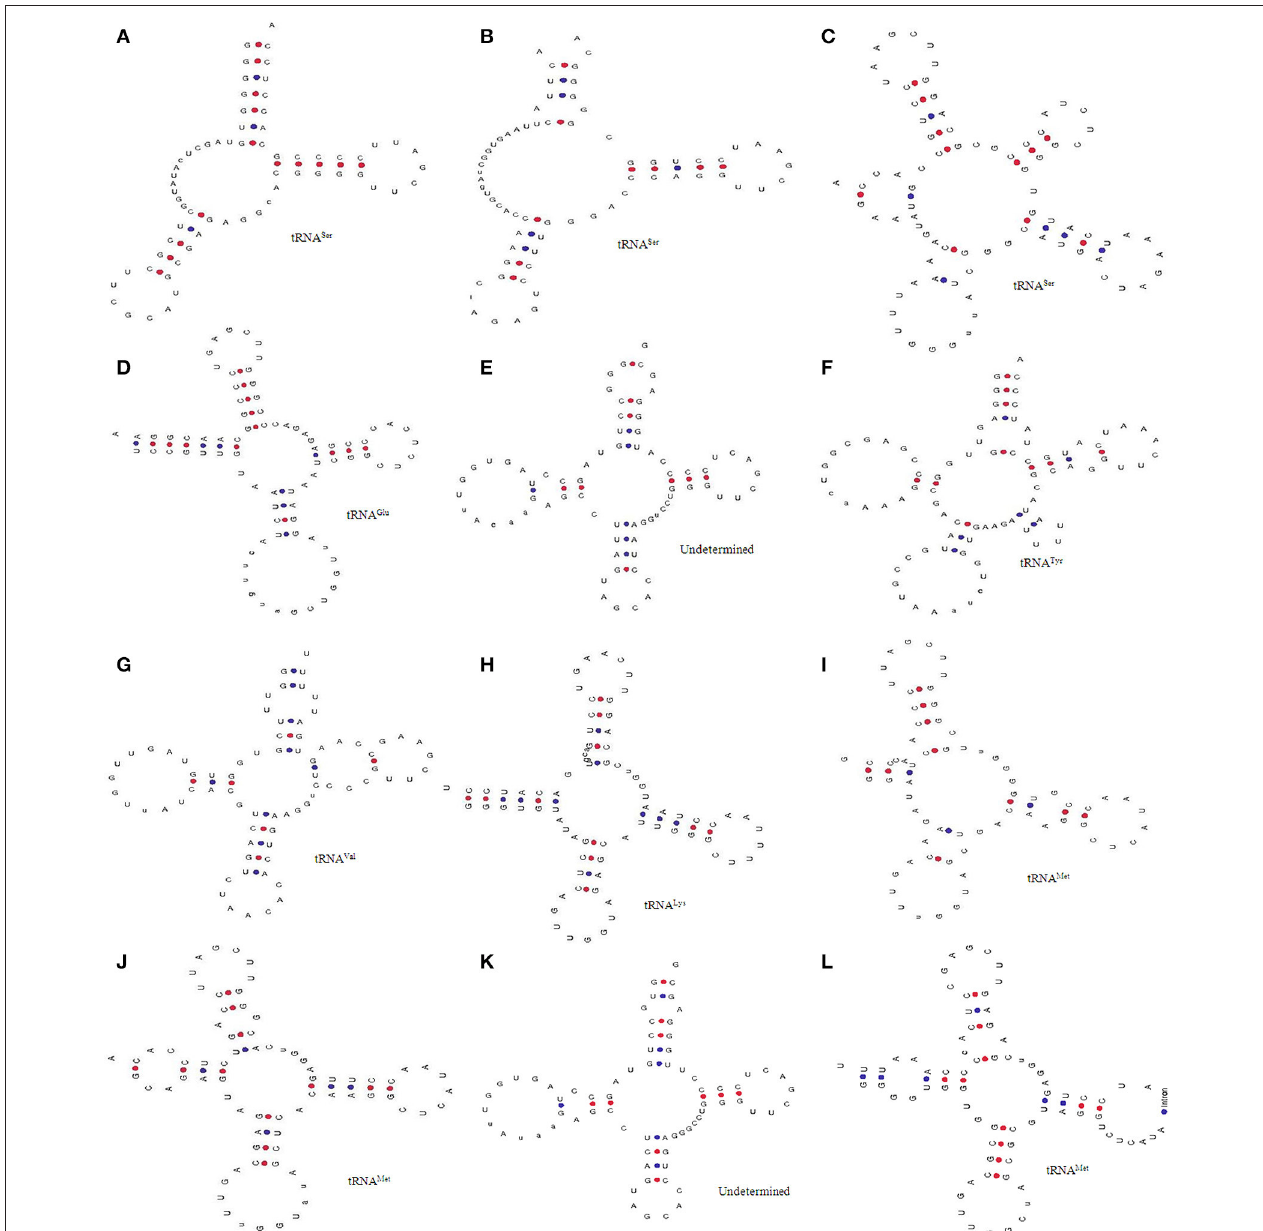
FIGURE 5 | Novel tRNAs of O. sativa . Analysis through tRNA scan revealed the presence of 14 novel forms of tRNA (denoted type A to L ). (A) D arm and D-loop was found to be absent, (B) D arm was found to be absent and it contained 17 nucleotides in between the acceptor arm and the anti-codon arm, (C) presence of loop like acceptor arm, (D) D-loop contained 15 nucleotides with modified bases, (E) bulged acceptor and D-arm, (F) bulged acceptor arm and the D-arm containd only two nucleotides (G) bulged acceptor arm and only three nucleotides in the D-arm, (H) one side of 9 -arm contained five nucleotides whereas other side contianed eight, (I) shorter acceptor arm having three nucleotides in one side whereas six in other side, (J) bulged acceptor and 9 -arm (K) bulged acceptor arm and D-arm, and (L) bulged acceptor arm and only four nucleotide in the anti-codon arm. These novel tRNA are might be responsible for novel functional roles in O. sativa